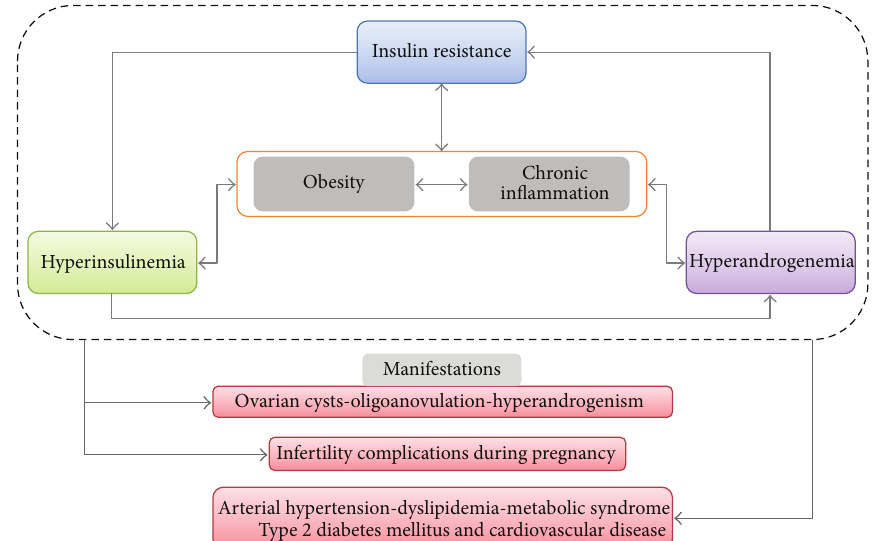
Figure 1: The insulin resistance-hyperinsulinemia-hyperandrogenemia cycle in Polycystic Ovary Syndrome. PCOS is dominated by three major endocrine disruptions: insulin resistance, hyperinsulinemia, and hyperandrogenemia. Although it is difficult to establish which disturbance develops first in any given case, these components are interconnected by many reinforcing mechanisms, constituting a positive feedback cycle. Furthermore, obesity and chronic inflammatory states—present in both obese and lean women with PCOS—amplify pathophysiologic pathways linked to all elements in this triad. The cycle leads to the manifestations of PCOS and infertility, complications during pregnancy, and chronic cardiometabolic